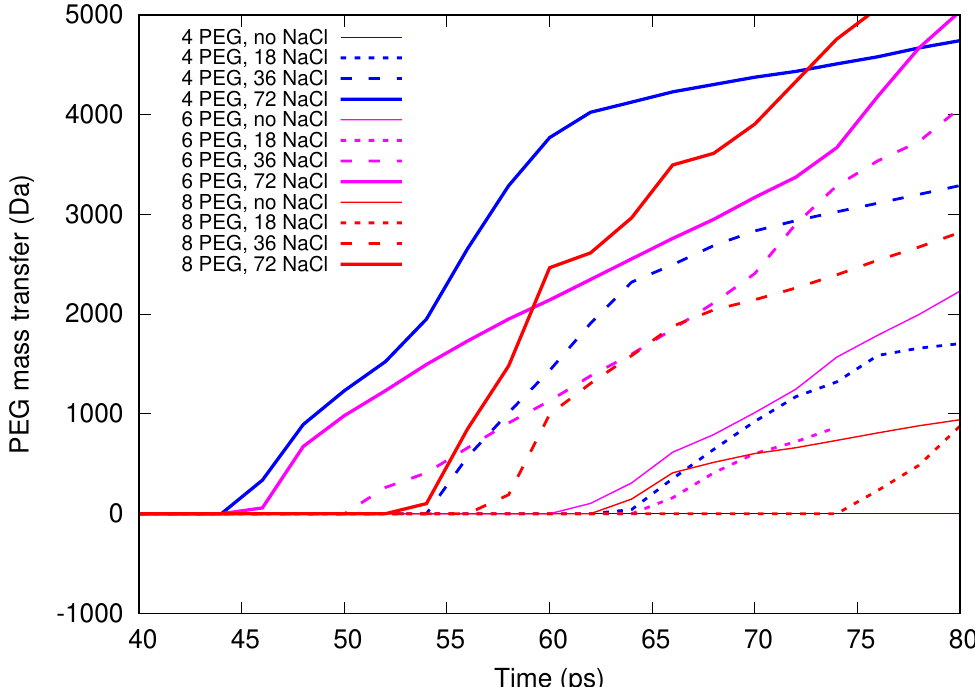
Figure 14. Mass of PEG transported through the plane at z = 20 nm as a function of production time for samples with 10.55-kDa PEG chains under 1.5 V/nm. Curves correspond to different numbers of chains and NaCl ion pairs, see the legend. Plotted with gnuplot [56].